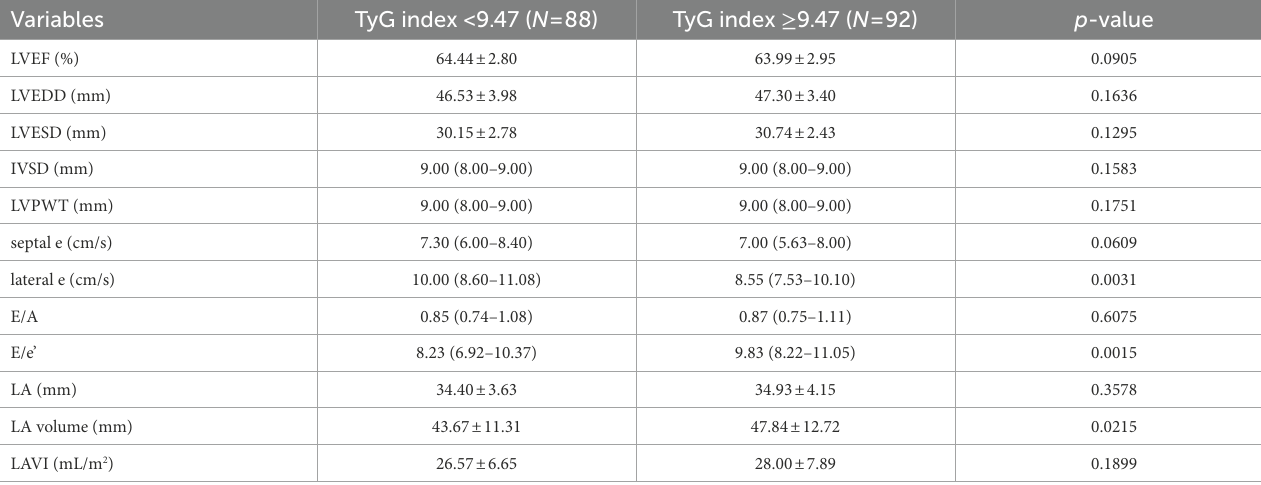
TABLE 2 Echocardiographic data of in T2DM patients stratified by binary TyG index. Variables